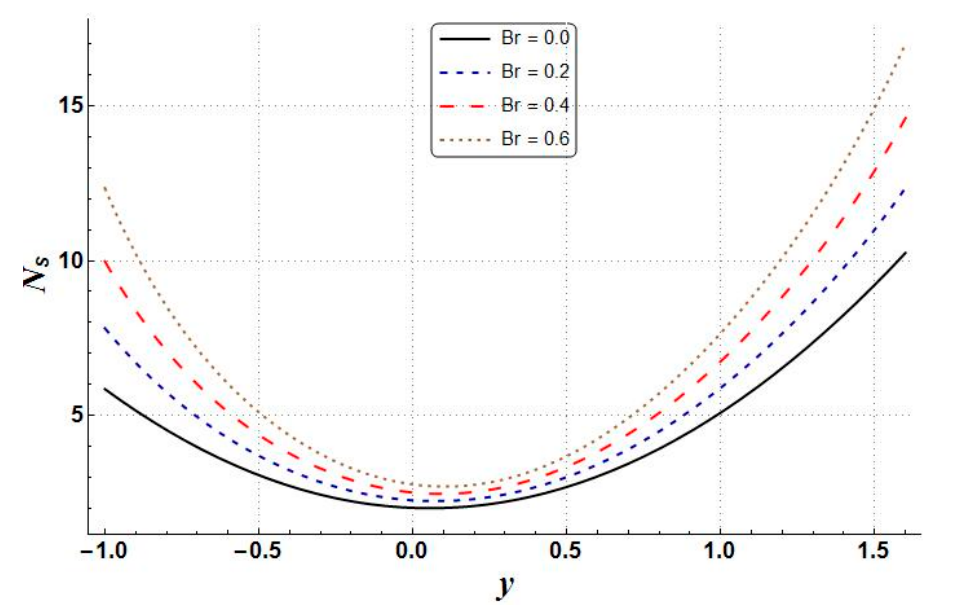
Figure 29. Influence on N S through changing values of Br , where γ = π φ = 0.05, k = 2, a = 0.6, M = 1, d = 0.7, m = 1, b = 0.5, ∈ = 2, η = 0.8.